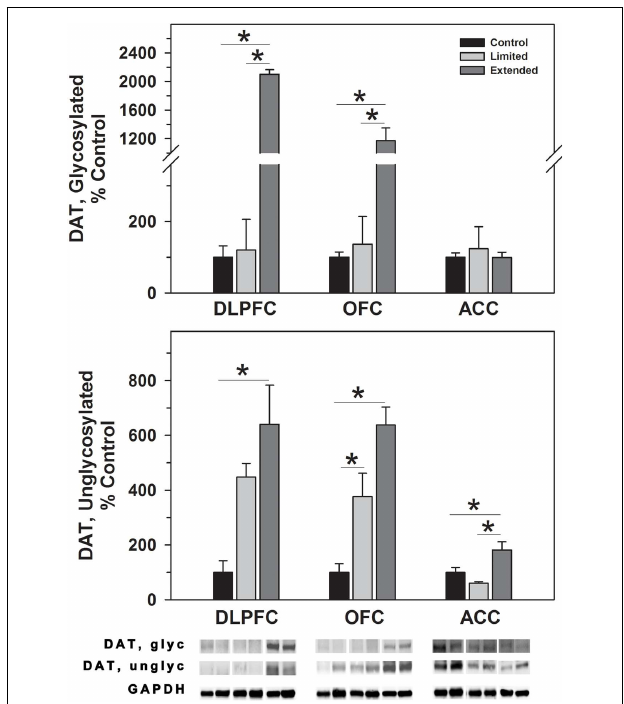
FIGURE 1 |Western blot analysis of glycosylated and non-glycosylated dopamine transporter protein levels in prefrontal regions following limited and extended access to cocaine self-administration . Membrane fractions were isolated as described in the Section “Materials and Methods” and 15 µ g were separated on 10% SDS-PAGE. Data are expressed as mean ( ± SEM) of the percent of control values per amount of protein loaded. Asterisks indicate a significant difference ( P < 0.05). Bottom Panel: Representative bands from two subjects per group per region.